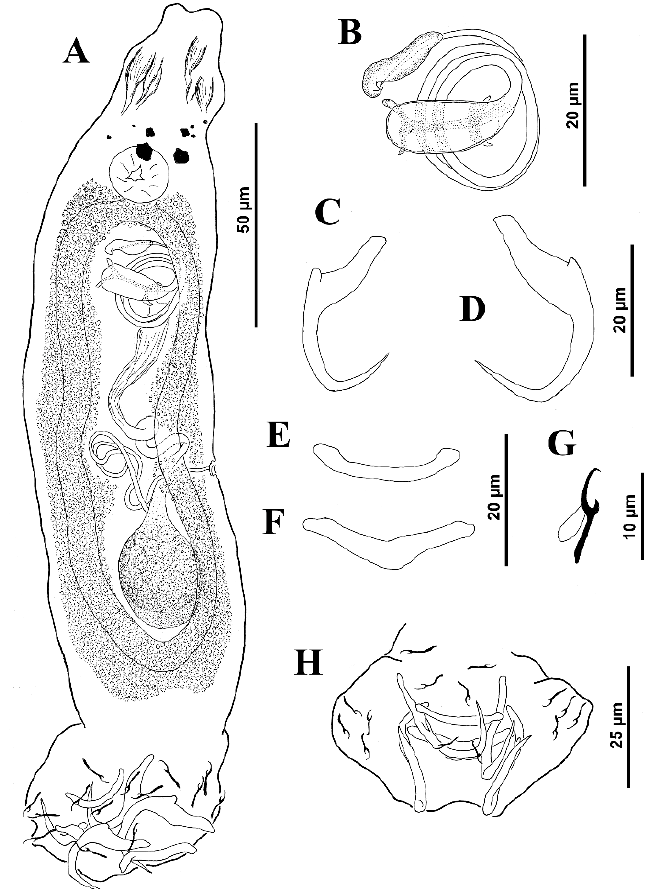
Figure 1. Paraeuryhaliotrema pomacentris n. gen., n. sp. from the beaugregory Stegastes xanthurus . ( A ) Whole mount (composite, dorsal view) ( B ) Copulatory complex (dorsal view) ( C ) Ventral anchor ( D ) Dorsal anchor ( E ) Ventral bar ( F ) Dorsal bar ( G ) Hook ( H ) Haptor. Vagina pore dextromarginal; vagina distally funnel shaped, proximal portion an elongate, meandering sclerotized duct before discharging into seminal receptacle situated anterior to germarium. Vitelline follicles scattered throughout trunk except in regions of reproductive organs. Egg not observed.